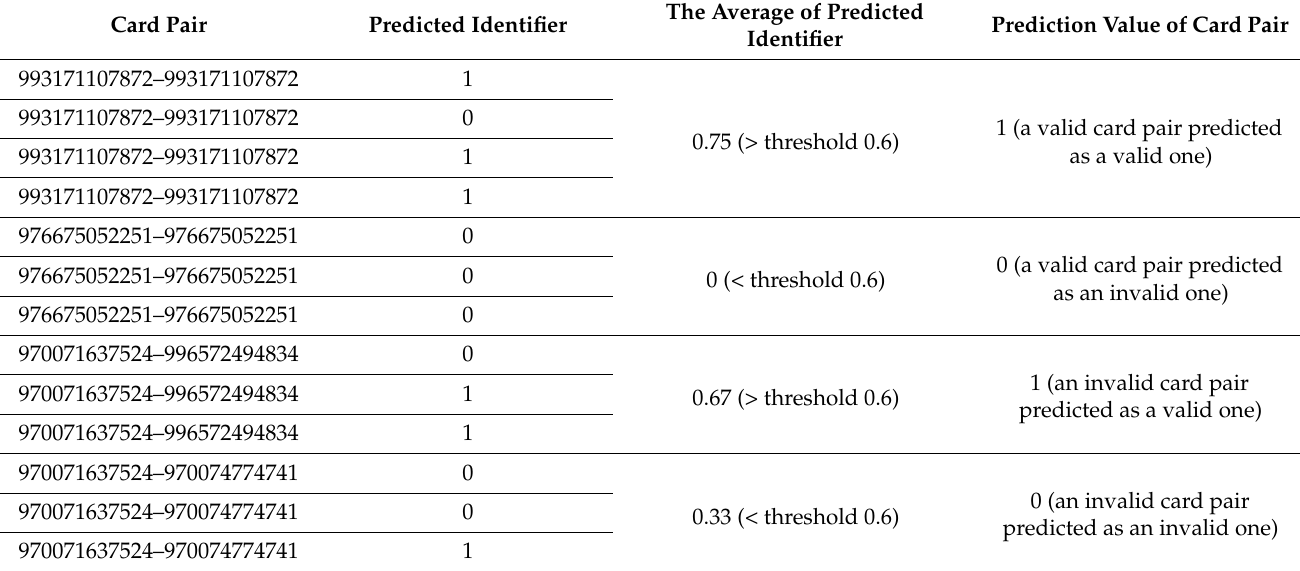
Table 2. Four types of prediction result for card